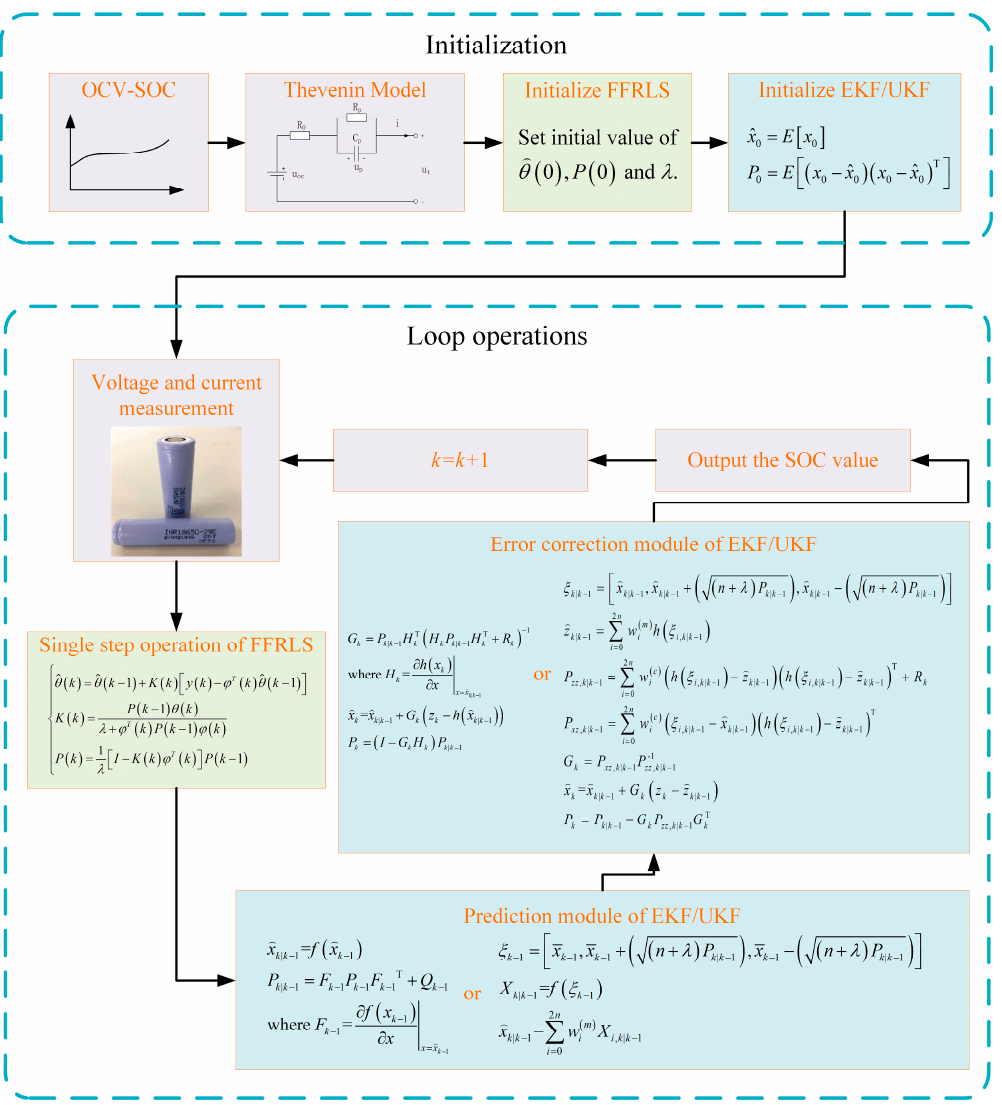
Figure 2. Schematic of joint algorithms.